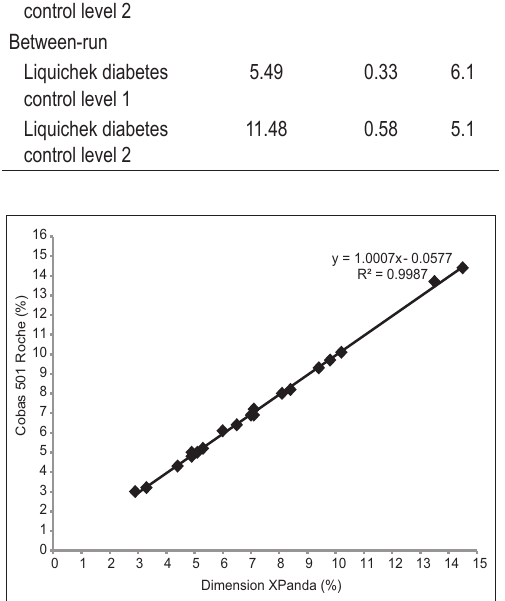
FIGURE 1. Correlation between the results of HbA1c whole blood using Dimension Xpand and Cobas 501 Roche